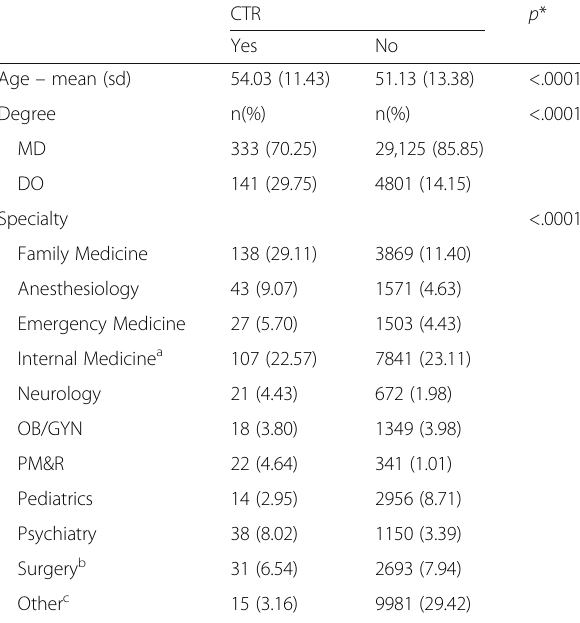
Table 3 Comparing CTR acquisition by Age, Degree, and Specialty using the Ohio Physician Roster ( N = 34,400)